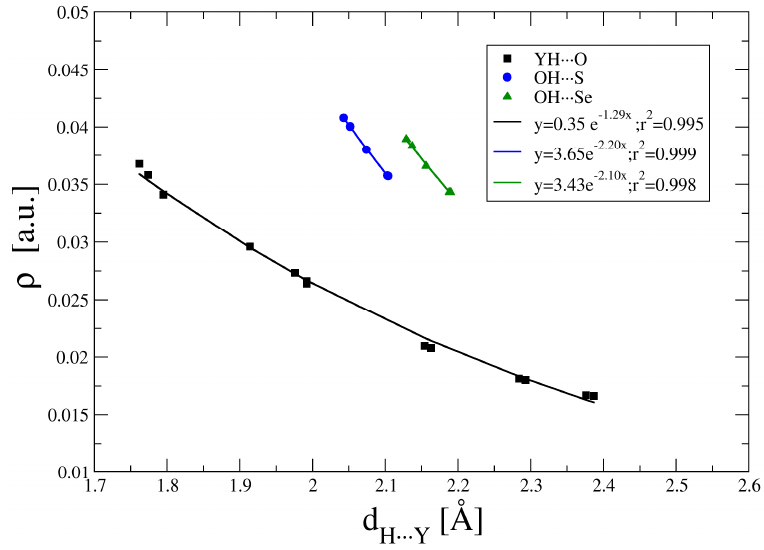
Figure 2. Electron density at the hydrogen bonds (HB) critical points vs. the interatomic